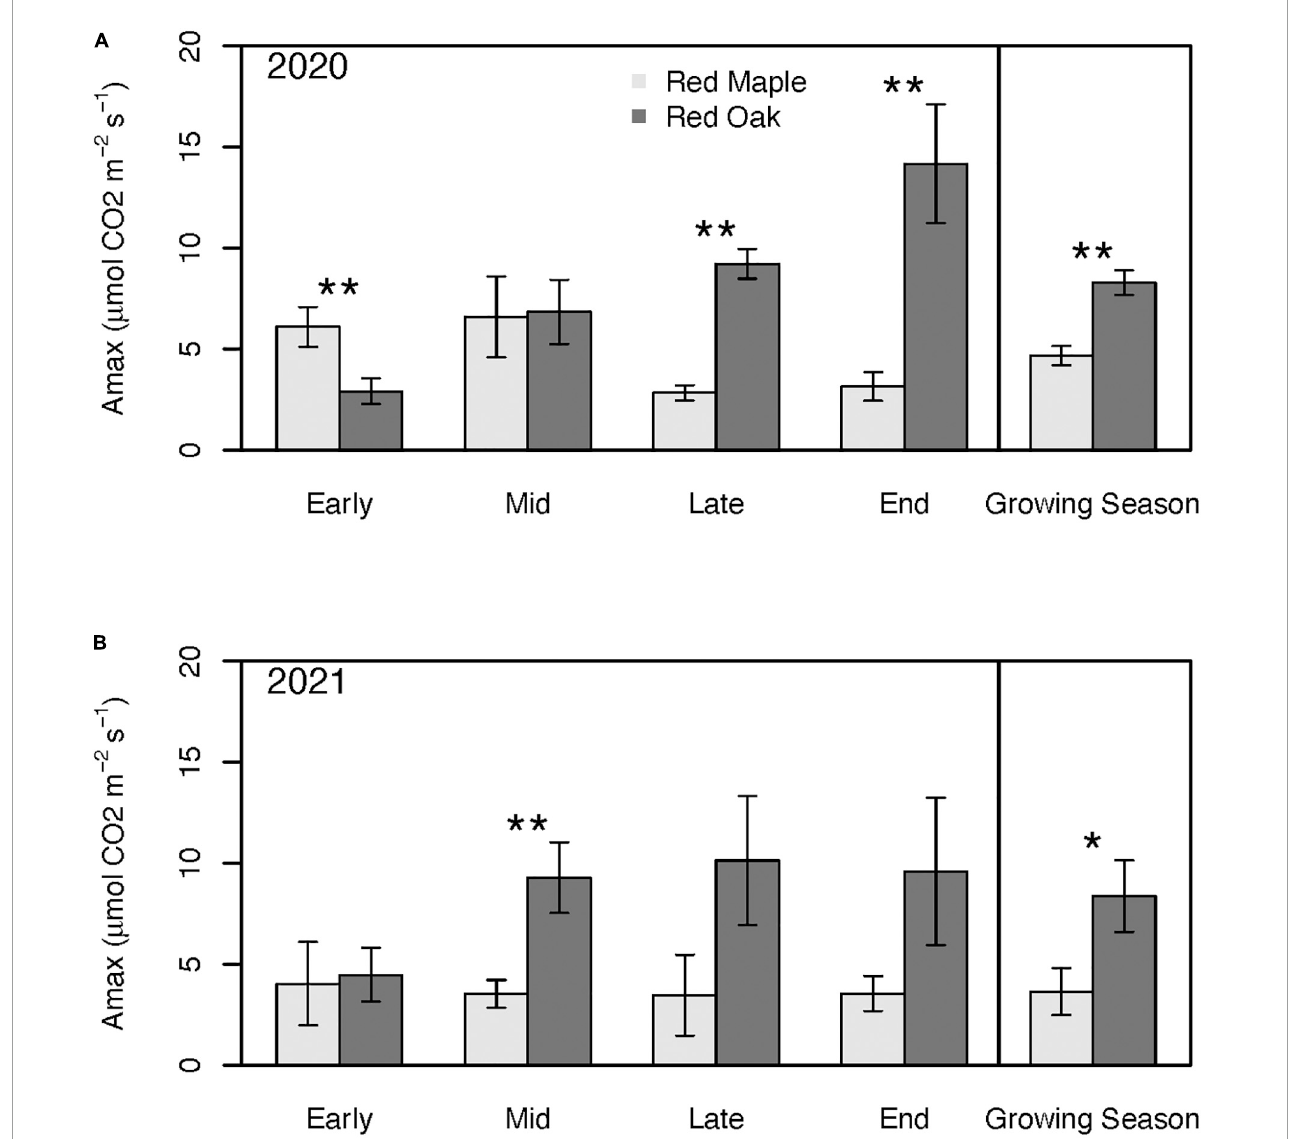
FIGURE5 Photosynthetic capacity across the growing season and for the mean of the entire growing season during 2020 (i.e., year with oak-defoliating frost) (A) and 2021 (i.e., year without defoliating frost); (B) for red maple and red oak leaves. Asterisks denote differences between species within a year at ** p < 0.05 and * p < 0.1. There were no significant interannual differences within a species. See Supplementary Tables 1A, B for summary